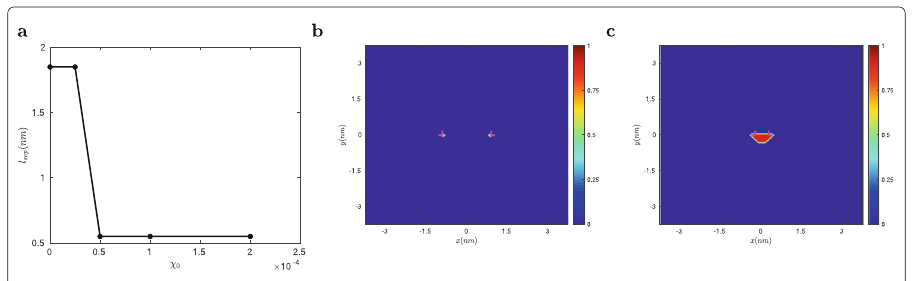
Fig. 5 a The stacking fault width as a function of χ 0 . b and c show the contours of the H concentration for = 2.5 × 10 − 5 and χ = 5 × 10 − 5 , respectively. The partial dislocations at their equilibrium positions are χ 0 0 marked by purple “ (cid:2) ” symbols in ( b ) and ( c